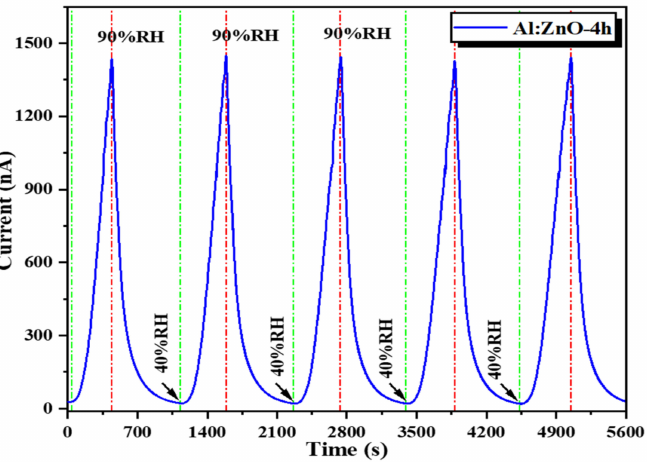
Figure 16. Repeatability behavior (response/recovery characteristic) of the Al:ZnO-4 h nanostructured-based flexible humidity